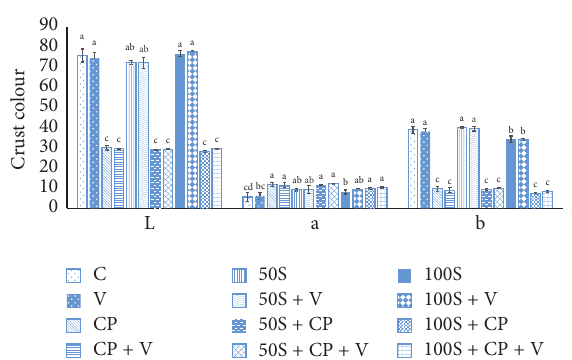
Figure 2: Effect of stevianna without/with cocoa powder and/or vanilla on the crust colour of muffin. Control (C); vanilla (V); cocoa powder (CP); cocoa + vanilla (CP + V); 50% stevianna (50S); 50% stevianna + vanilla (50S + V); 50% stevianna + cocoa (50S + CP); 50% stevianna + cocoa + vanilla (50S + CP + V); 100% stevianna (100S); 100% stevianna + vanilla (100S + V); 100% stevianna + cocoa (100S + CP); 100% stevianna + cocoa + vanilla (100S + CP + V).